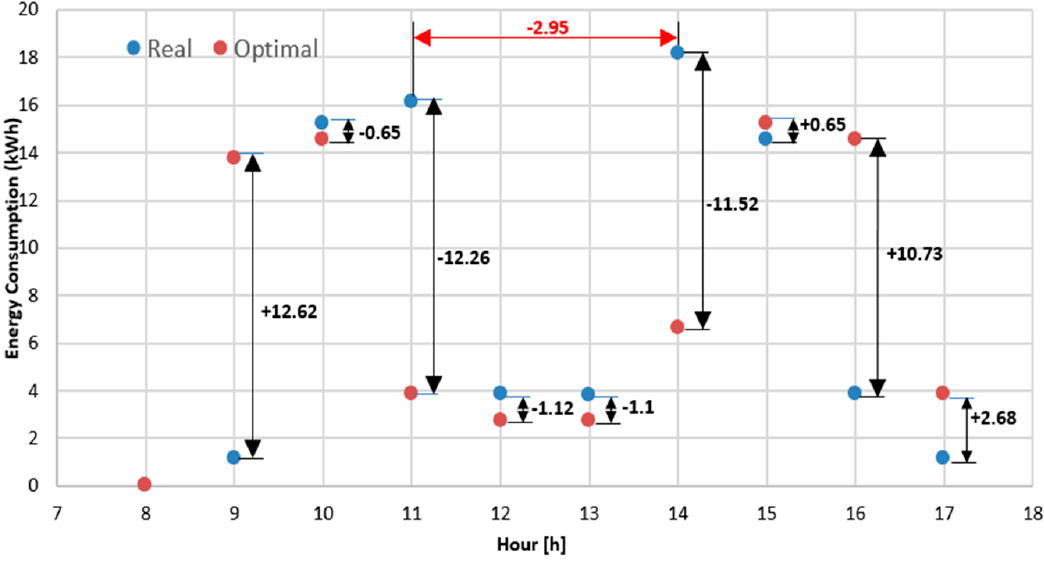
Figure 17. The differences between the real and optimal hourly energy consumptions.